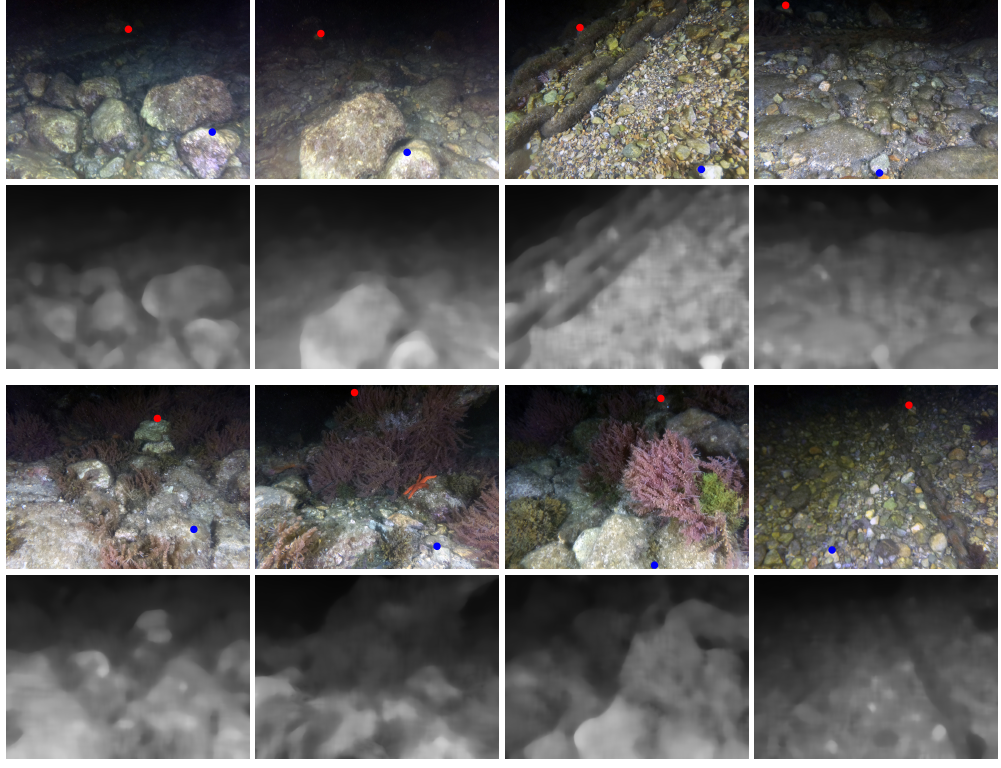
Figure 6. Examples of underwater images taken with our system and the computed rough depth using only the luminance channel. The rough depth was used later to speed up the stereo matching procedure. The red dots show the minimum detectable disparity ( ≈ 130 pixels in 10 cm baseline setup), while the blue dots show the maximum disparity ( ≈ 450 pixels in 10 cm baseline setup). See Figure 3 for corresponding distances and conversion to other